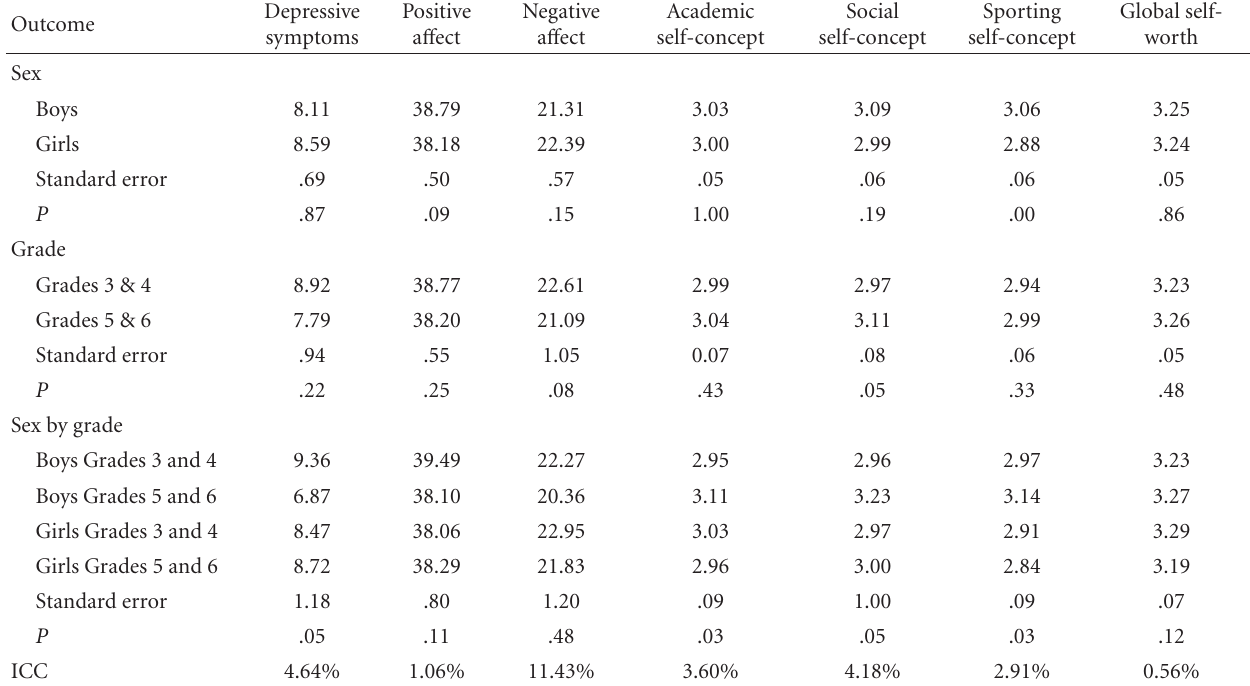
Table 1: Mean scores and main e ff ects of sex and grade and the sex by grade interaction for depressive symptoms, a ff ect, and self-concept. Outcome